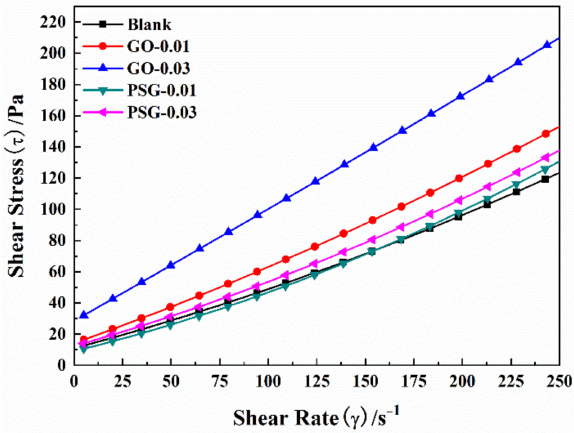
Figure 8. Diagram of M–B model-fitting